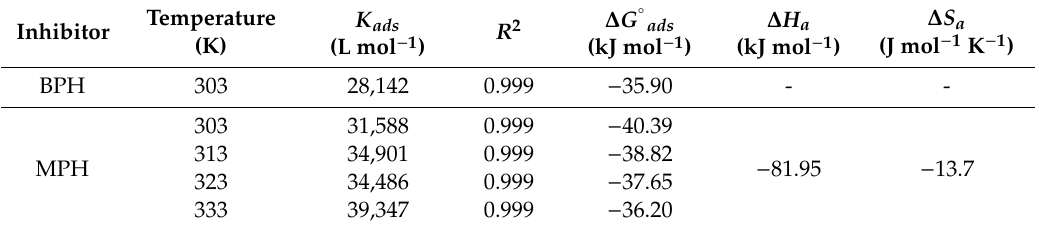
Table 9. Thermodynamic parameters of MS corrosion in the presence of MPH and BPH in 1.0 M HCl. Inhibitor